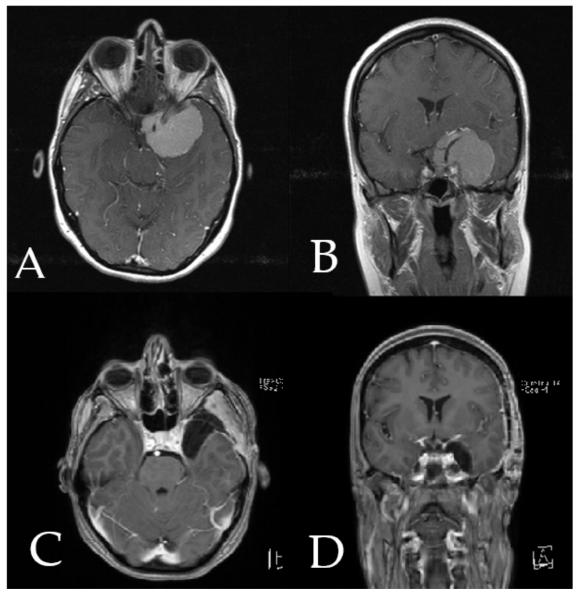
Figure 6. Preoperative axial ( A ) and coronal ( B ) T1-weighted post-contrast MRI of the head in patient number 9 shows a large medial sphenoid wing meningioma with encasement of carotid and cerebral medial artery. Postoperative axial ( C ) and coronal ( D ) postcontrast MRI of the head shows complete resection of the tumor.